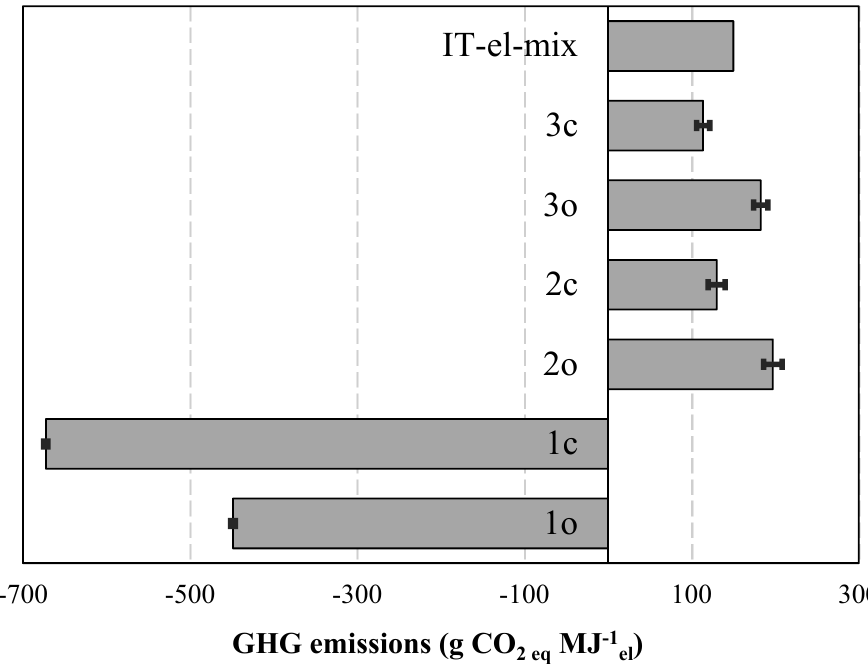
Figure A4. Results of the assessment of the sensitivity of the total GHG emissions to the variability of field emissions. The grey bars represent the total GHG emissions of the analysed systems, the black error bars represent how the total GHG emissions range by varying the field emissions by + or −